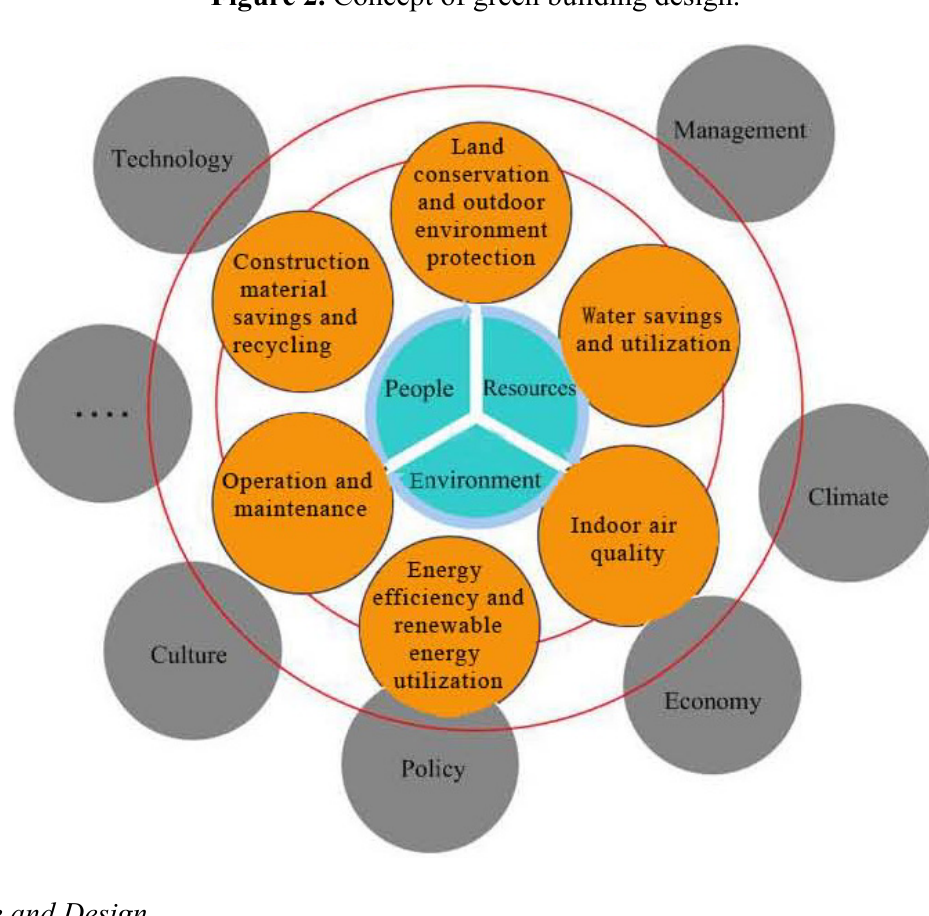
Figure 2. Concept of green building design.